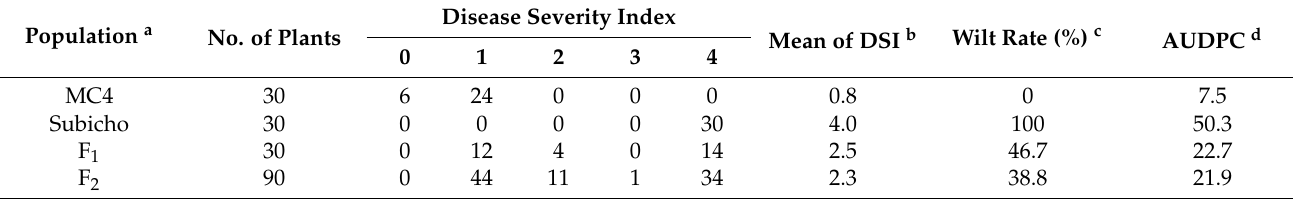
Table 2. Disease evaluation design and the number of plants to parents and their progenies based on disease severity index in 20 dai against R. solanacearum SL1931 strain.